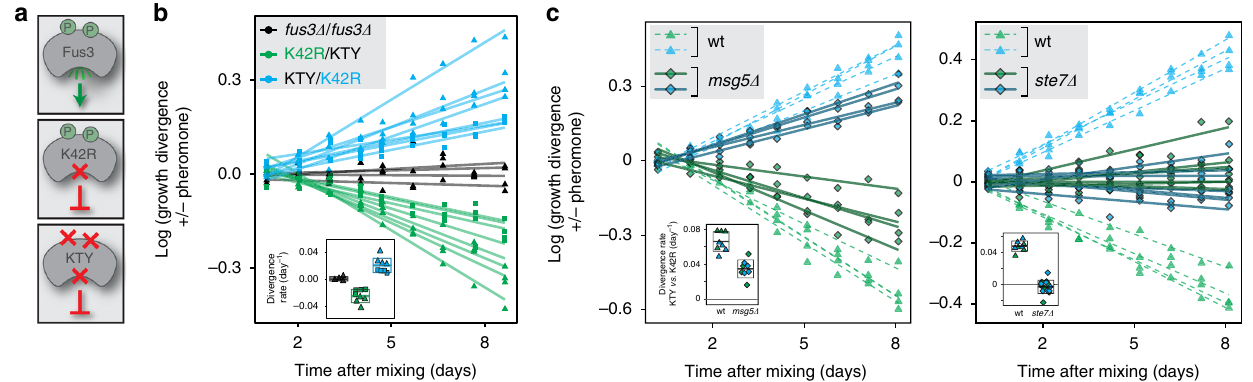
Fig. 5 Continuous dephosphorylation/phosphorylation of enzymatically inactive Fus3 lowers competitive growth fi tness. a Schematic depiction of employed Fus3 variants. A single amino acid replacement renders Fus3-K42R and -KTY enzymatically inactive and thus incapable of transmitting the signal. Fus3-KTY additionally carries amino acid replacements at both phosphorylation sites. b Fitness cost of phosphorylation cycle, monitored over time as the ratio between mNeongreen (Ng)- and mTurquoise (Tq)-expressing cells grown in a co-culture in the presence of pheromone (20 nM), normalized to the corresponding ratio in absence of pheromone. Different colours depict co-cultures of competing strains that carry different fus3 alleles and fl uorescent markers: fus3 Δ + Ng vs. fus3 Δ + Tq (black), fus3-K42R + Ng vs. fus3-KTY + Tq (green) and fus3-KTY + Ng vs. fus3-K42R + Tq (blue). For each pair, four co-cultures per genotype with independent transformants were tested. Co-cultures were grown for several days with re-inoculation twice a day and fl ow cytometric measurements once a day to determine ratios of Ng- to Tq-expressing cells. Combinations of fus3-K42R - and -KTY -expressing cells were analysed in two independent experiments (depicted by different symbols), while control of fus3 Δ vs. fus3 Δ was analysed in one experiment. Lines are linear fi ts for individual co-cultures. Slopes derived from these fi ts quantify the rate of divergence of Ng/Tq ratios between co-cultures grown in the presence and absence of pheromone (Inset). Centres and boundaries of boxes in the Inset depict means + / − s.d.; colouring for different co-cultures is according to the main plot. In pairwise comparisons using two-sided t test, p value was 7.08e − 5 with 95% con fi dence interval (CI) ranging from 0.0169 to 0.0338 for fus3 Δ - fus3 Δ (black, n = 4 biologically independent samples) against K42R - KTY co-cultures (green, n = 4 biologically independent samples examined over 2 independent experiments) and p value was 9.0e − 4 with CI from − 0.0287 to − 0.0105 for fus3 Δ - fus3 Δ (black) against KTY - K42R co-cultures (blue, n = 4 biologically independent samples examined over 2 independent experiments). c Fitness of mutants with reduced dephosphorylation rate ( msg5 Δ , left) or abolished phosphorylation ( ste7 Δ , right) compared to wild type. Wild-type pairs (wt, symbols and colours as in b , dashed lines for linear fi ts) in co-cultures were same as in b . Each of those strains was subjected to gene deletion and the resulting deletion strains (one and two clones per parental strain for msg5 Δ and ste7 Δ , respectively) were grown in co-cultures (diamond symbols, solid lines for linear fi ts) in a competition experiment alongside parental/wild-type co-cultures. Insets show divergences of ratios between fus3-KTY - and -K42R -expressing cells between co-cultures grown in the presence or absence of pheromone, as derived from the slopes of linear fi ts shown in the main fi gures. Centres and boundaries of boxes in the inset depict means + / − s.d. In pairwise comparisons with two-sided t test, p value was 4.62e − 5 with CI from 0.0198 to 0.0429 for wild type ( n = 8 biologically independent samples) ( n = 16 biologically independent samples) co-cultures. To increase throughput, co-cultures were grown here in 96-well plates without shaking, which